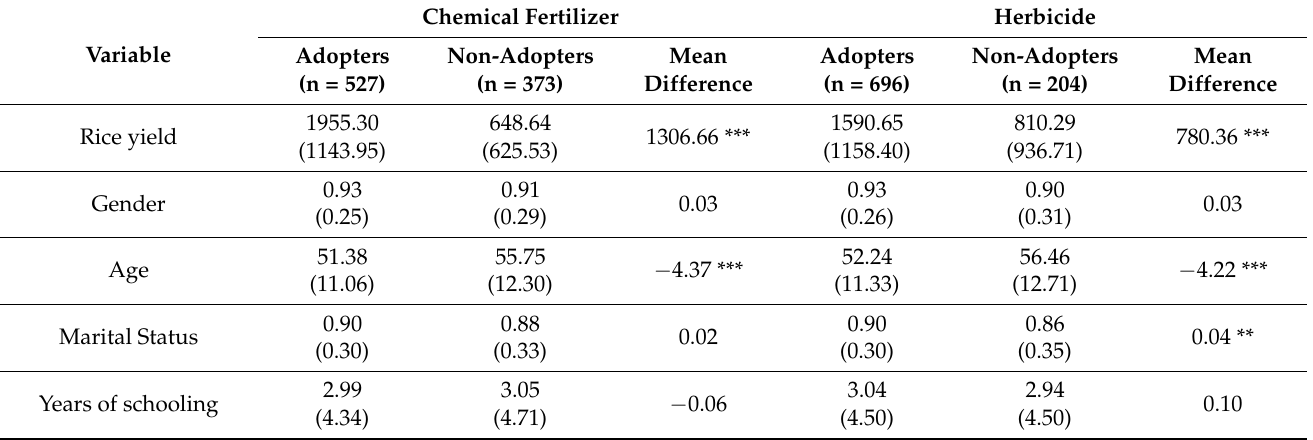
Table 2. Summary